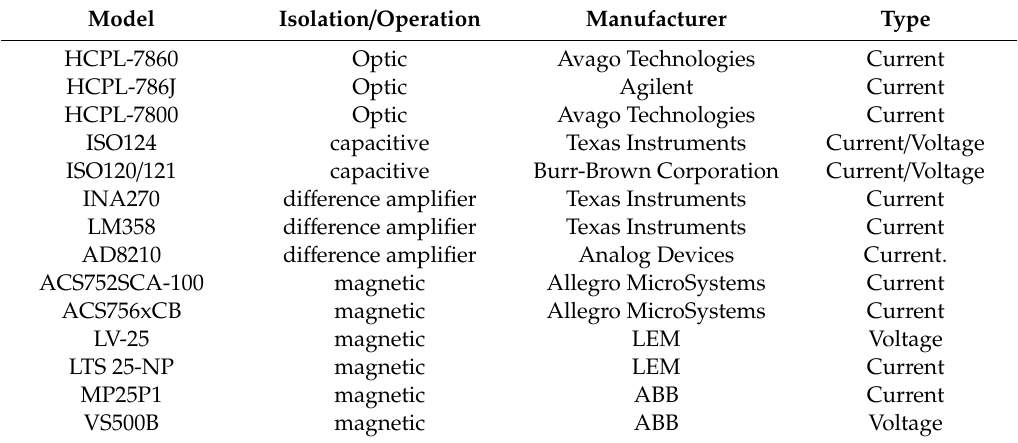
Table 2. Selected available voltage and current measurement amplifiers and transducers.